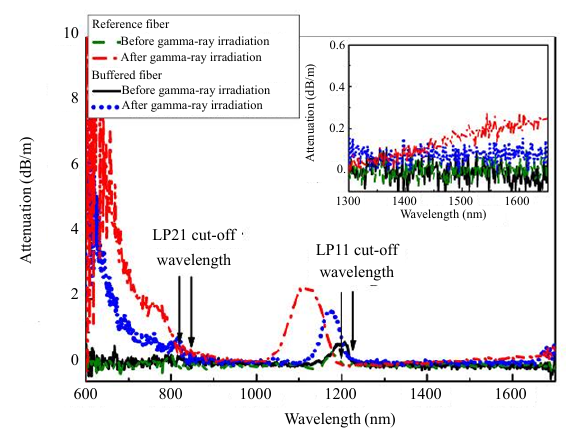
Fig. 5 Optical attenuation of the buffered and reference fibers before and after the γ -ray irradiation with the total dose of 22.85 kGy at room temperature in air (the inset represents the magnified view the attenuation spectra from 1300 nm to 1650 nm).